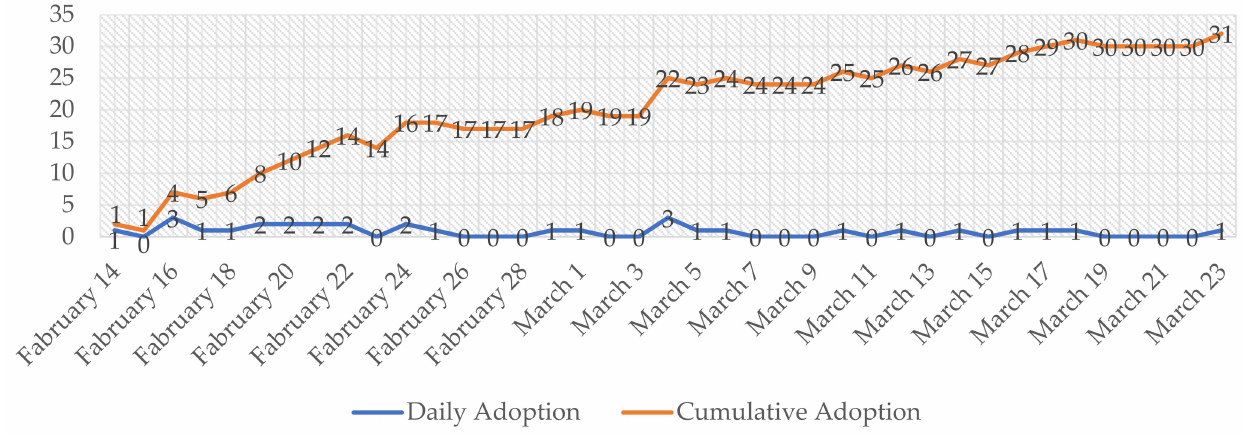
Figure 1. The number of provincial governments adopting health code apps.